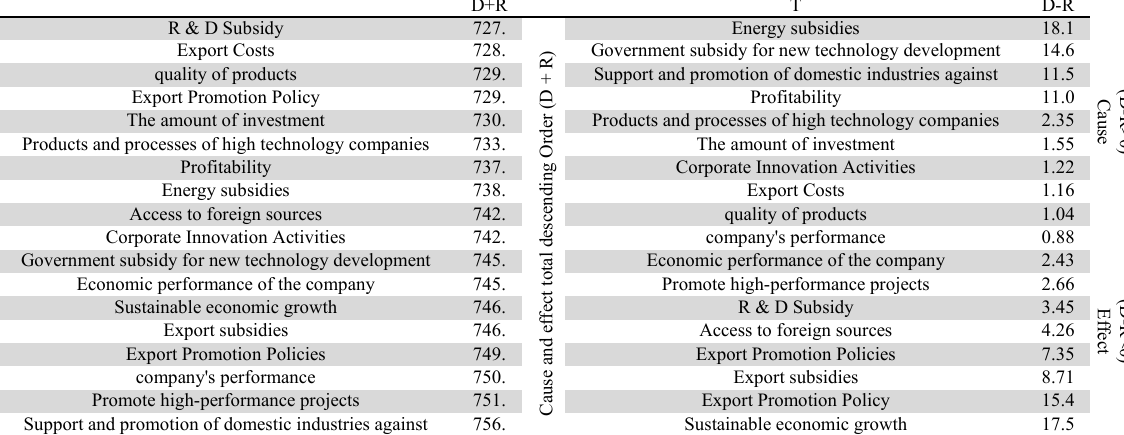
The summary of cause and effect